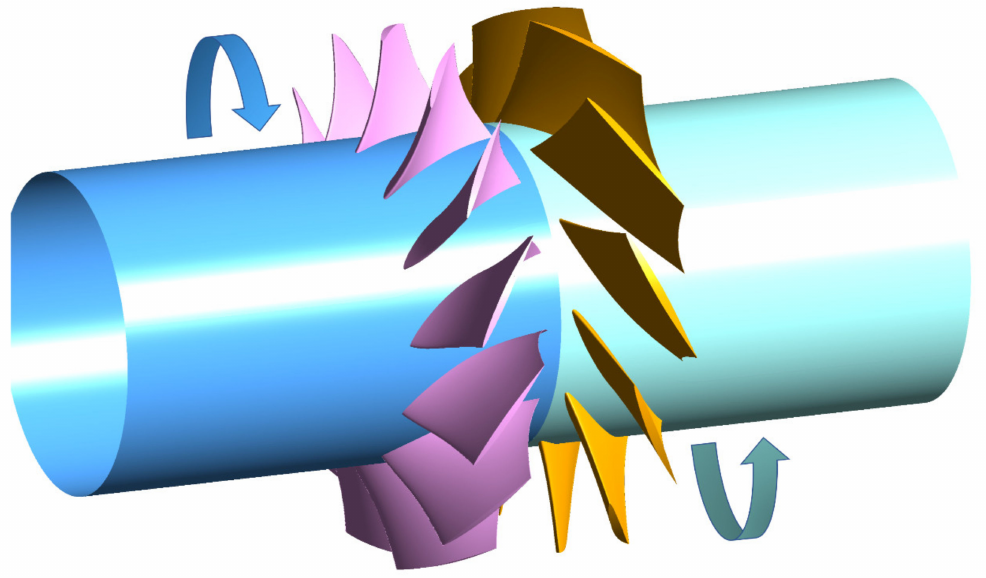
Figure 2. The baseline CRF